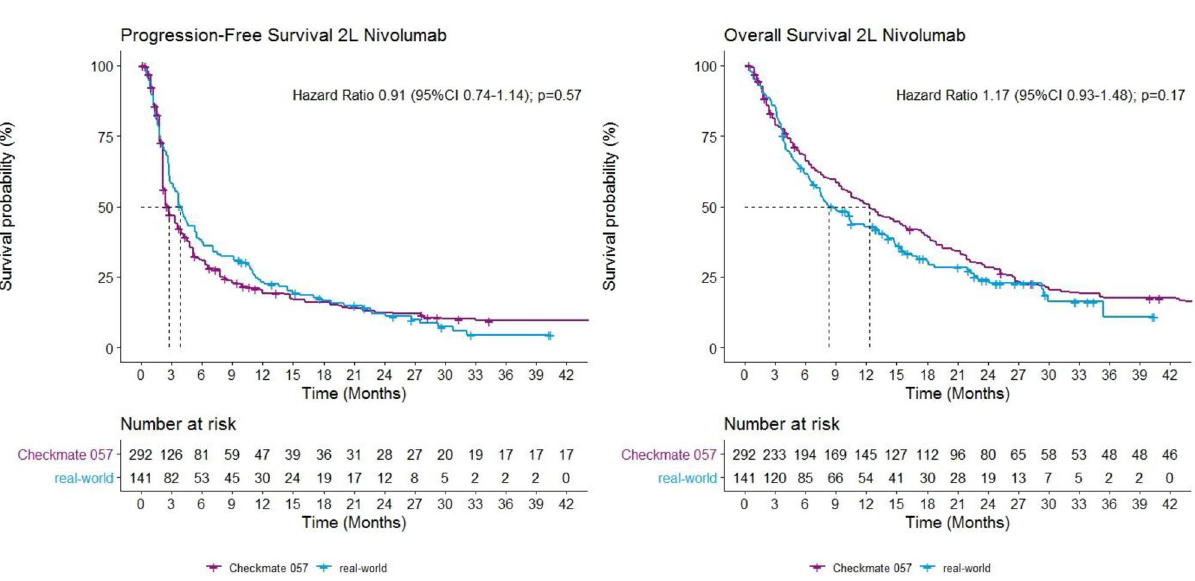
Figure 3. Kaplan–Meier curves of PFS and OS in patients receiving 2L nivolumab in real-world and clinical